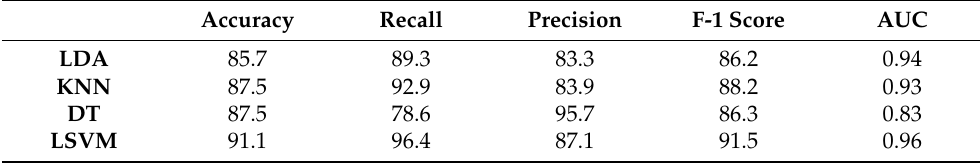
Table 2. Performance of the different types of classifiers for the 2D and VR viewing conditions.